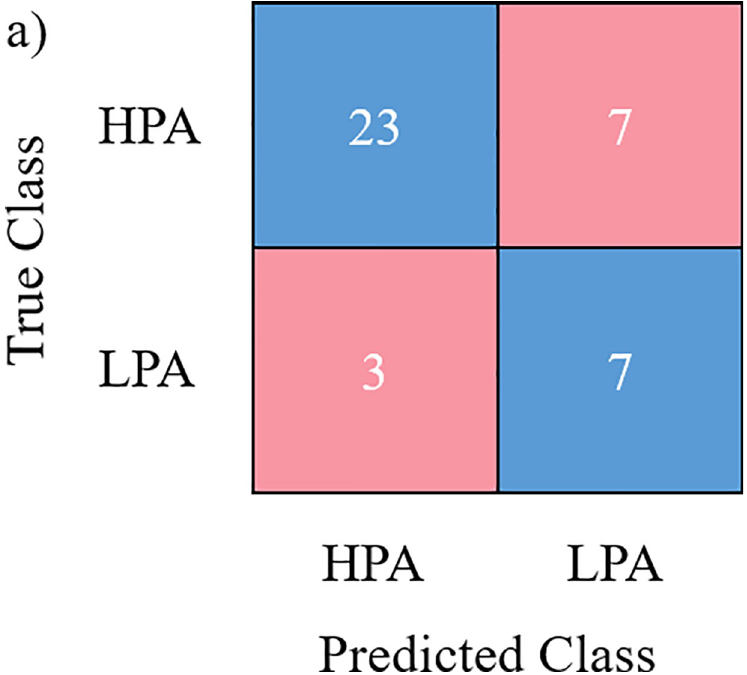
Fig 2. Confusion matrix. (a) Fine; (b) Medium; (c) Coarse; (d) Cosine; (e) Cubic; (f) Weighted; (g) Logistic